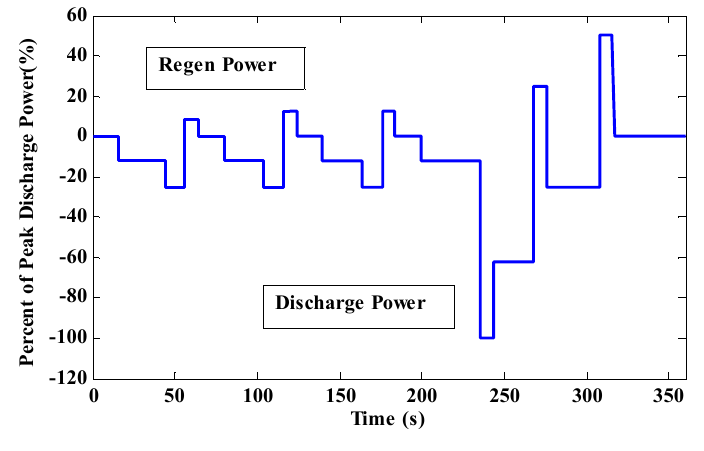
Figure 10. DST power profile for one